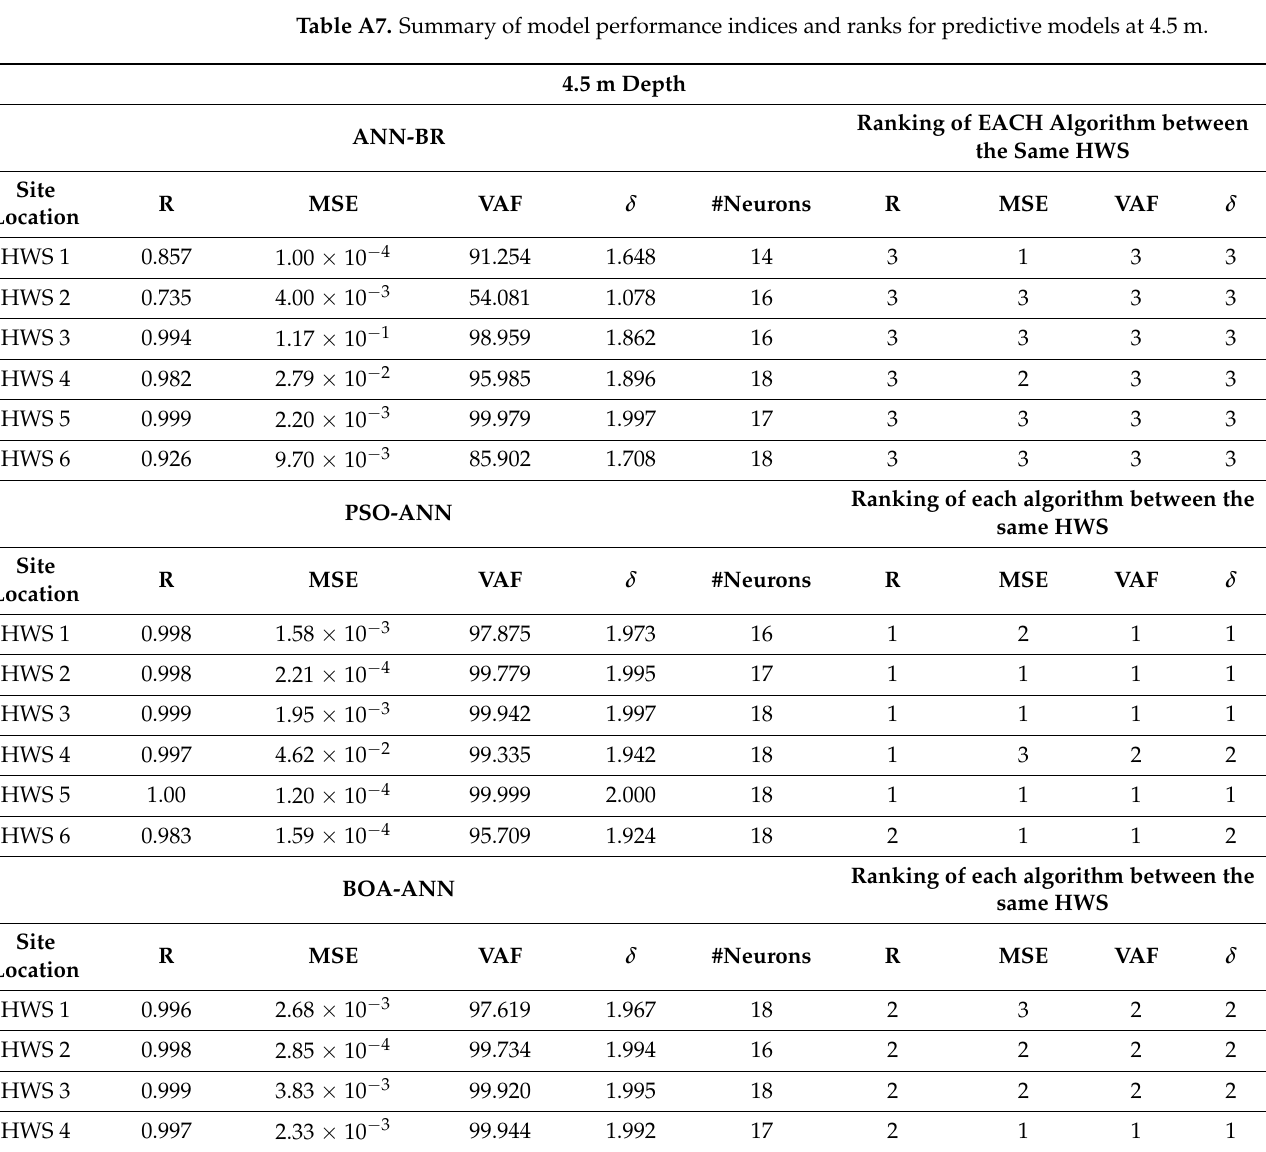
Table A7. Summary of model performance indices and ranks for predictive models at 4.5